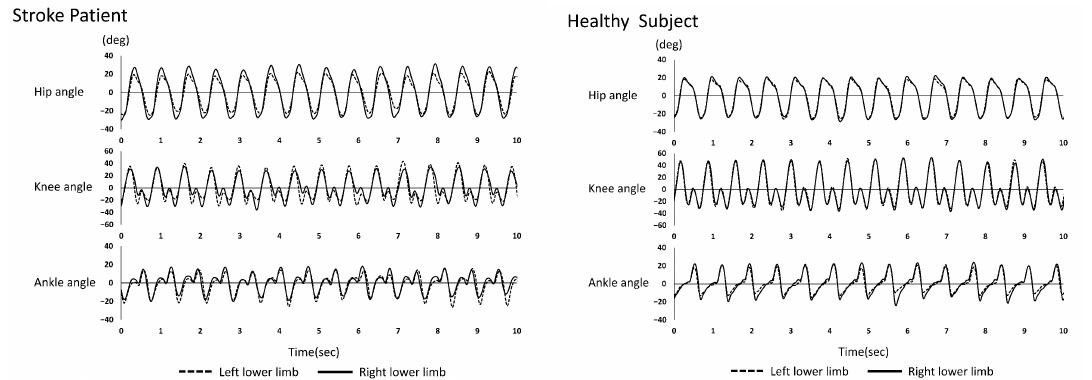
Figure 1. Representative examples of joint angles of the lower limbs during running in the stroke patient and the healthy subject are shown. The left figure shows the stroke patient, and the right figure shows the healthy subject. The upper panel shows the hip joint, the middle panel shows the knee joint, and the lower panel shows the ankle joint. Note that the left and right joint angles were shown superimposed after the time axis was matched.